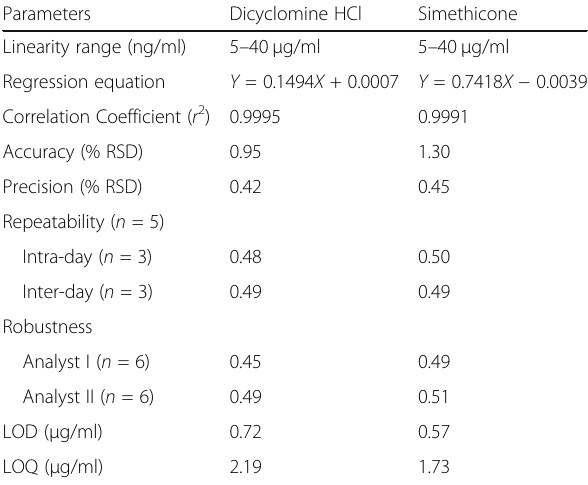
Table 9: Summary of validation parameters